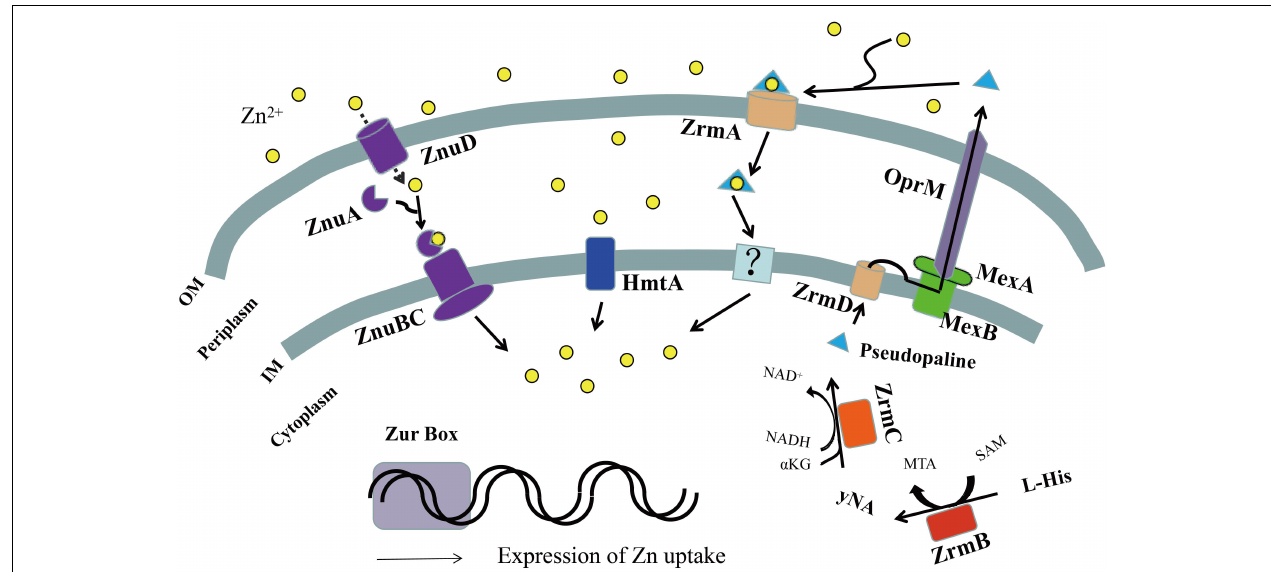
FIGURE 2 | Schematic representation of zinc uptake systems in Pseudomonas aeruginosa . In zinc-limited environments, the transcription regulator zinc uptake regulator (Zur) could not bind DNA as a repressor, leading to the expression of zinc uptake systems. The TonB-dependent transporters (ZnuD) located in the outer membrane allow the import of extracellular Zn 2 + in the free form, directly into the periplasm. The periplasmic space protein ZnuA transmits it to the ZnuBC transporter complex of the inner membrane, further inside the cytoplasm. Periplasmic Zn 2 + can also be imported into the cytoplasm via the P-type ATPase, HmtA. Pseudopaline synthesized by ZrmBC is released into the periplasmic space through the plasma membrane transporter ZrmD, then exported into the extracellular space through the MexAB-OprM efflux pump, where free Zn 2 + ions are chelated extracellularly to form the pseudopaline-Zn 2 + complex. The complex is then transported into the periplasmic space by the outer membrane receptor ZrmA and moved into the cell by an unknown inner membrane transporter or unloaded Zn 2 + to complete extracellular Zn 2 + uptake. OM, outer membrane; IM, inner